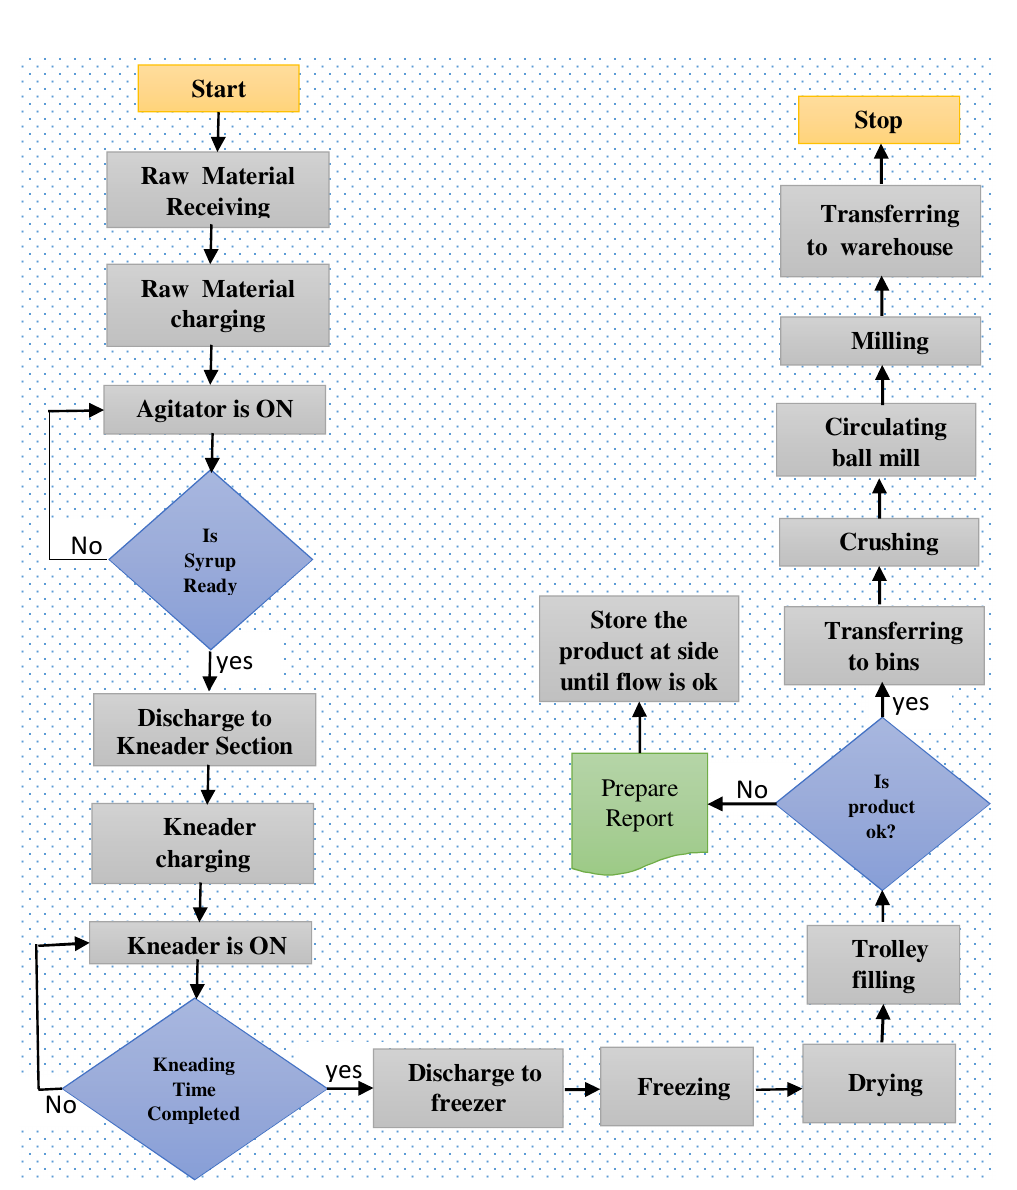
Fig. 2: Process Flow Layout in DYNEA